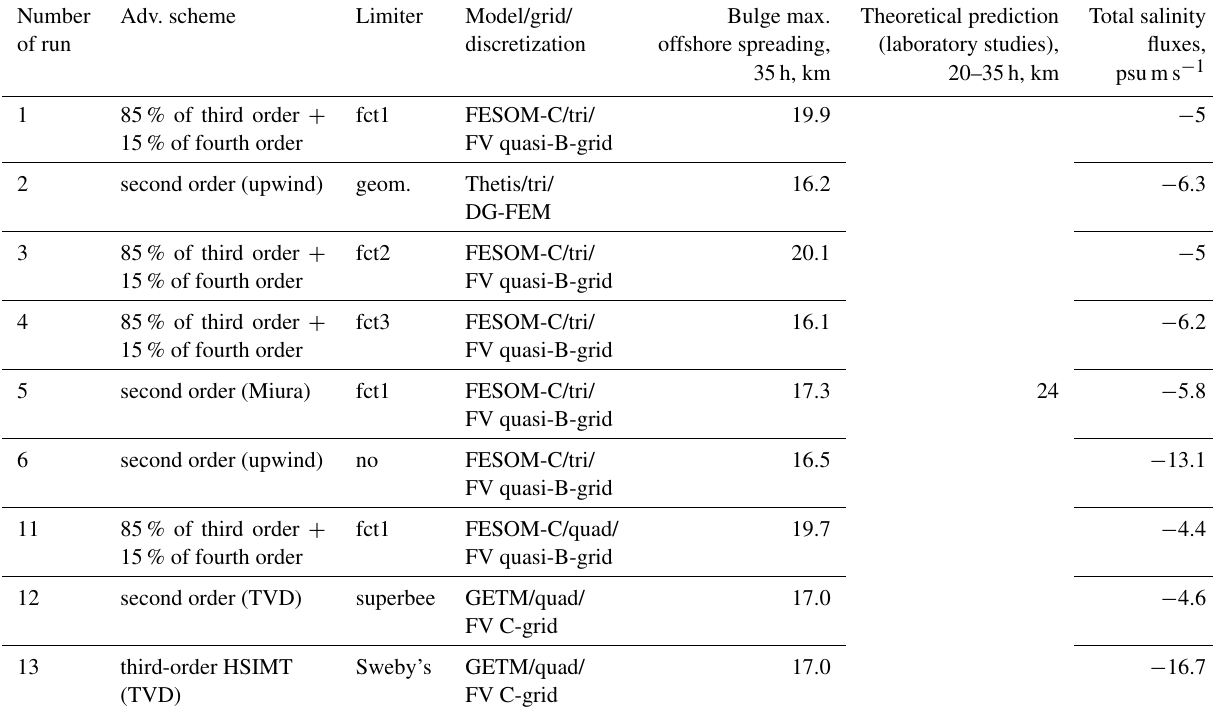
Table 3. The description of runs and their results with respect to changes in the advection scheme and limiter types. The discharge in all setups was equal to 3000m 3 s − 1 ; 40 vertical layers were used, and eddy viscosity coefficient was calculated based on a second-order